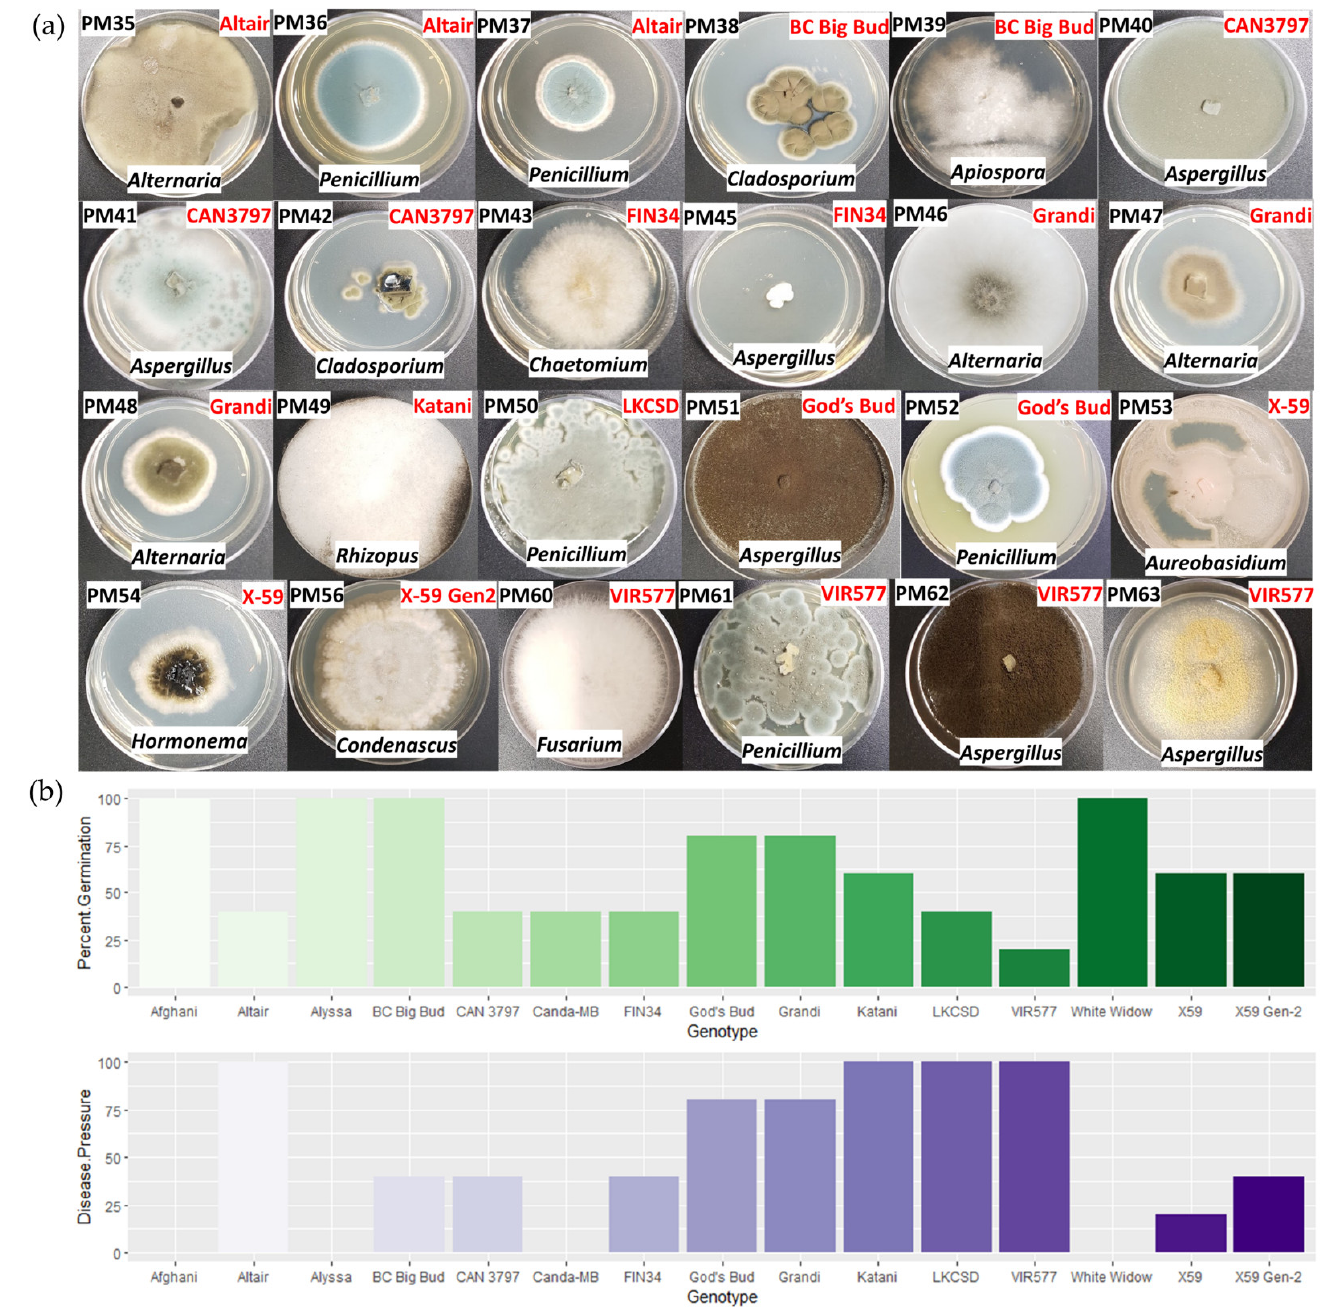
Figure 4. Seed-Borne Fungi from Cannabis . ( a ) Fungal isolates from seeds of 15 Cannabis accessions germinated on PDA for 5 days. ( b ) Germination rates and percent of seeds with visible mycelia growth (disease pressure) for each Cannabis